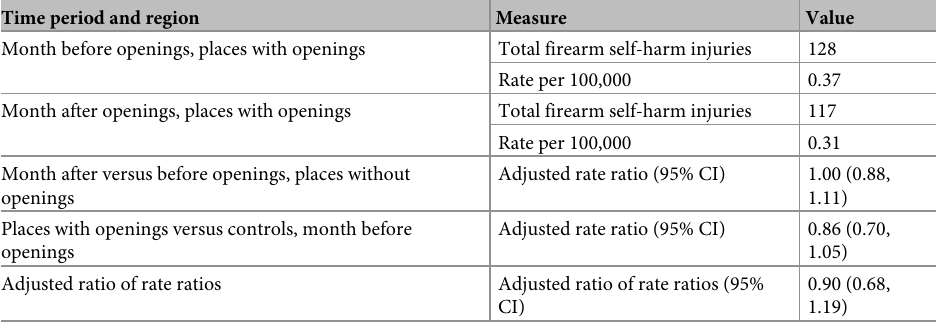
Table 3. Crude and adjusted rates of firearm self-harm in the month before and after dealer openings in at-risk regions local to these events.